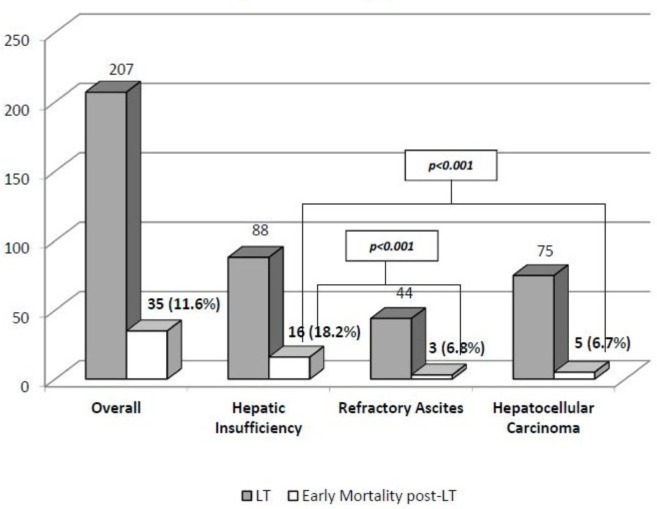
Exclusion rates of WL